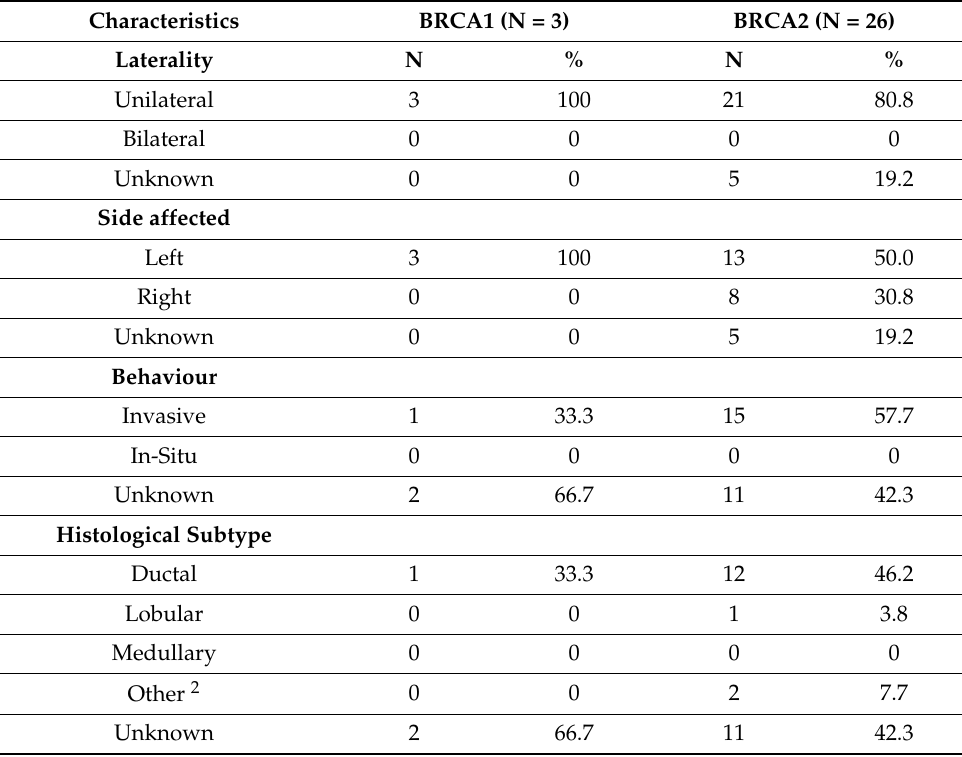
Figure 2. Primary cancer cases by mutation status. Table 3. Primary breast tumor characteristics by mutation type 1 . Characteristics BRCA1 (N = 3) BRCA2 (N = 26)